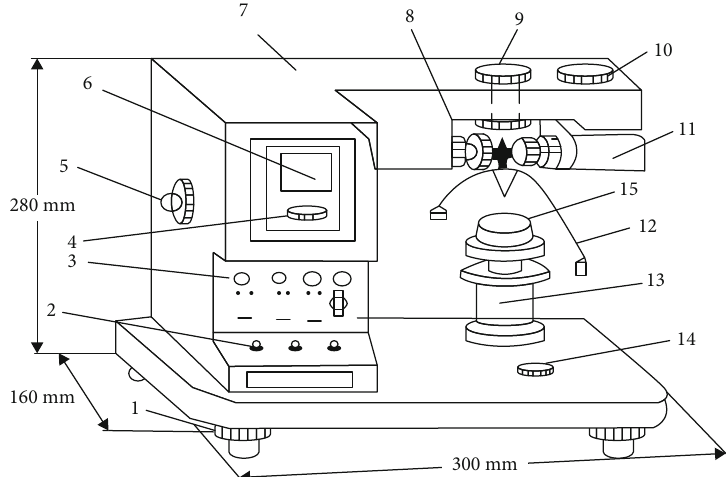
Figure 2: Schematic diagram of photoelectric liquid/plastic limit testing machine: (1) water adjusting screw; (2) control switch; (3) indicator light; (4) zero line adjusting screw; (5) re fl ector adjusting screw; (6) screen; (7) housing; (8) objective adjustment screw; (9) battery devices;